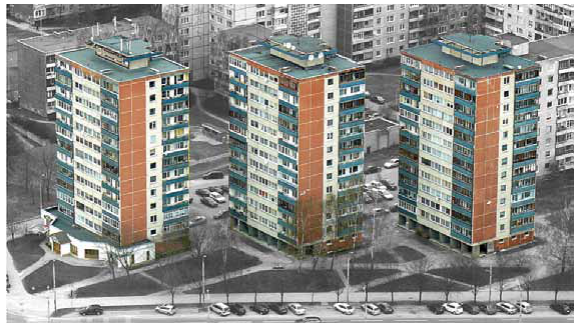
Fig. 3. 12-storey tower blocks in Karoliniškės (series